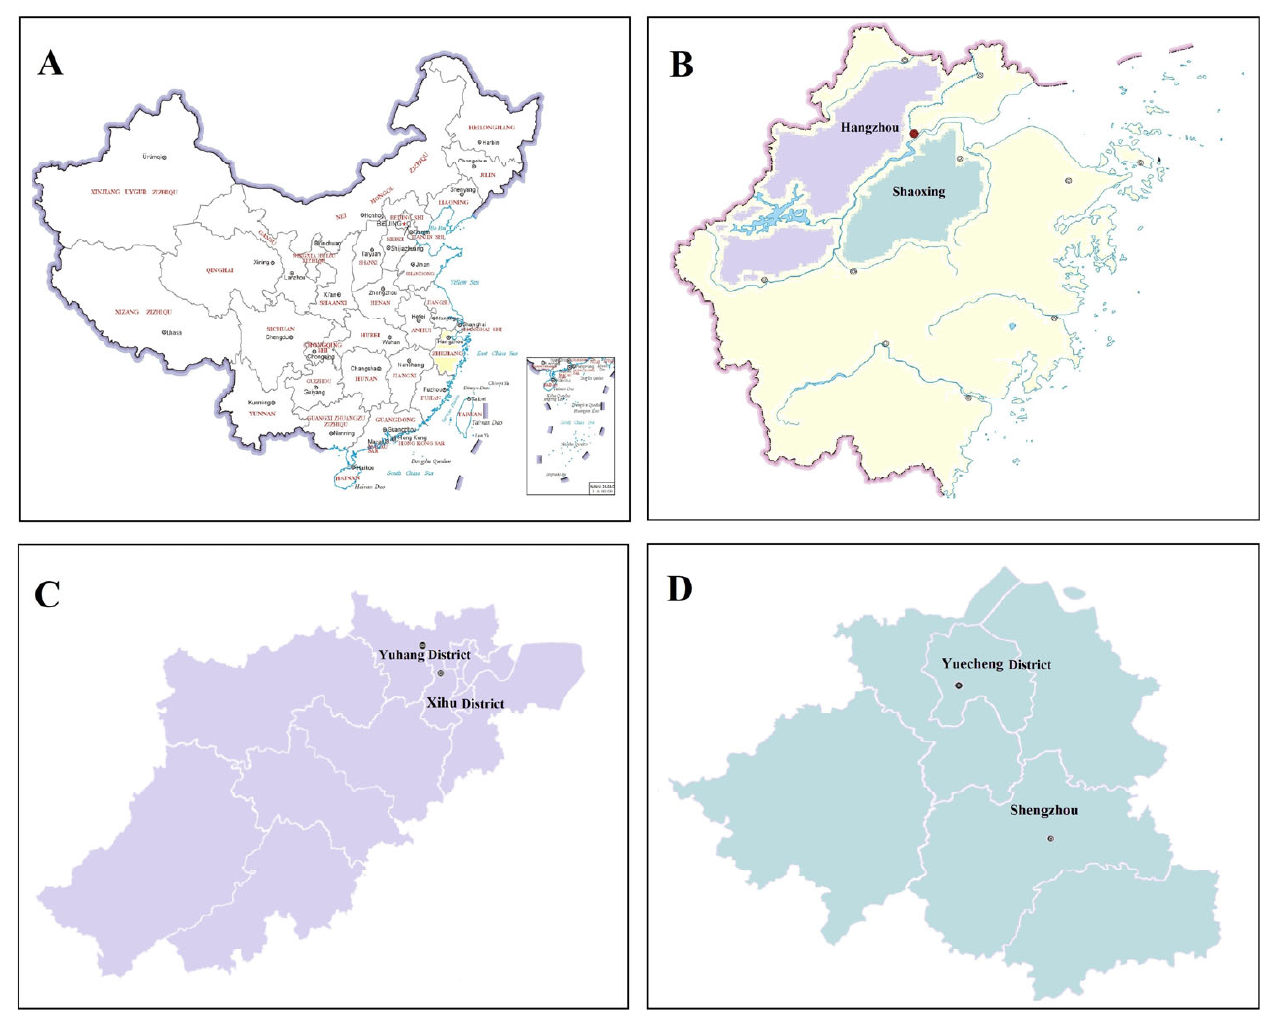
Figure 1. Map of China with the study areas shaded. Thrips trapping sites and study locations are indicated by the circles. ( A ). China; ( B ). Zhejiang Province; ( C ): Hangzhou City; ( D ): Shaoxing City.